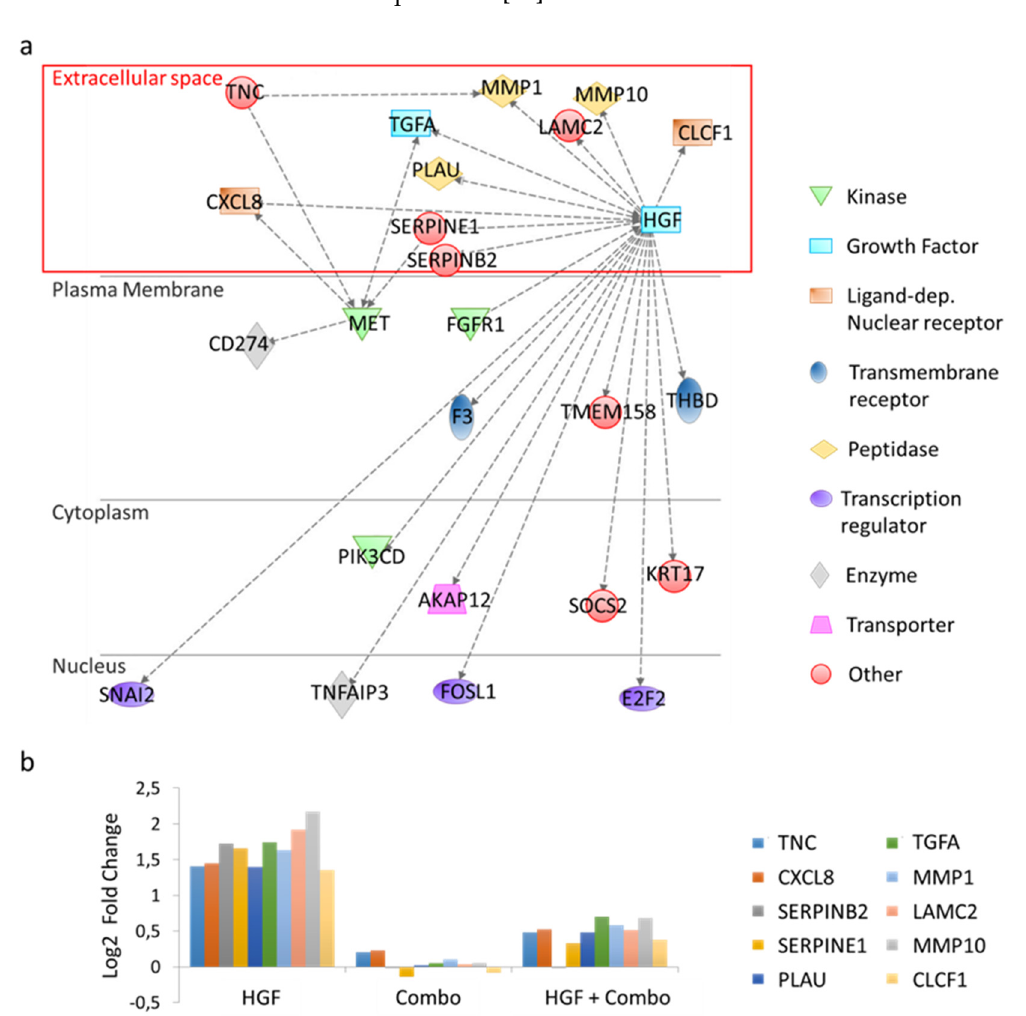
Figure 3. Ingenuity Pathway Analysis (IPA) of differentially regulated genes in HGF-treated versus HGF + Combo-treated HPAF-II cells. ( a ) Functional network generated by IPA including genes involved in indirect interactions with HGF and/or MET. Genes acting as intermediate bridges between HGF or MET are not shown. Nodes represent genes, dotted lines represent indirect biological relationships between nodes. The red box highlights genes encoding for proteins secreted in the extracellular space. ( b ) Bar graph reporting differential expression of genes encoding proteins secreted in the extracellular space. Values have been normalized versus untreated cells.